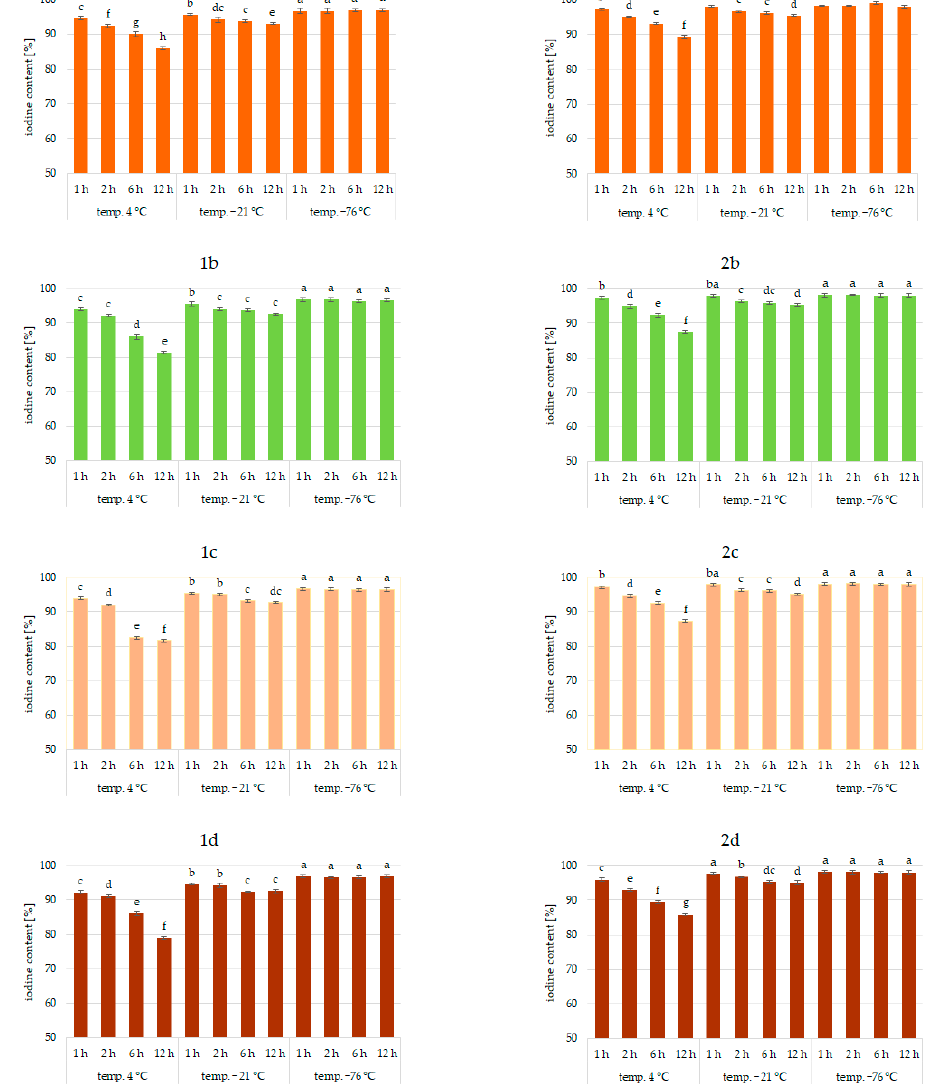
Figure 3. Iodine content (%) in pumpkin ( 1a , 2a ), broccoli ( 1b , 2b ), cauliflower ( 1c , 2c ), and carrot ( 1d , 2d ) fortified with KI and KIO 3 , respectively, at hydration ratio 1:4 and different temperatures (4 °C, − 21 °C, − 76 °C) and times; different letters (a–h) denote a significant difference at p < 0.05 (one-way ANOVA, and post hoc Tukey test). Mean values ( n = 4). Error bars are confidence intervals with a confidence coefficient of 0.95.